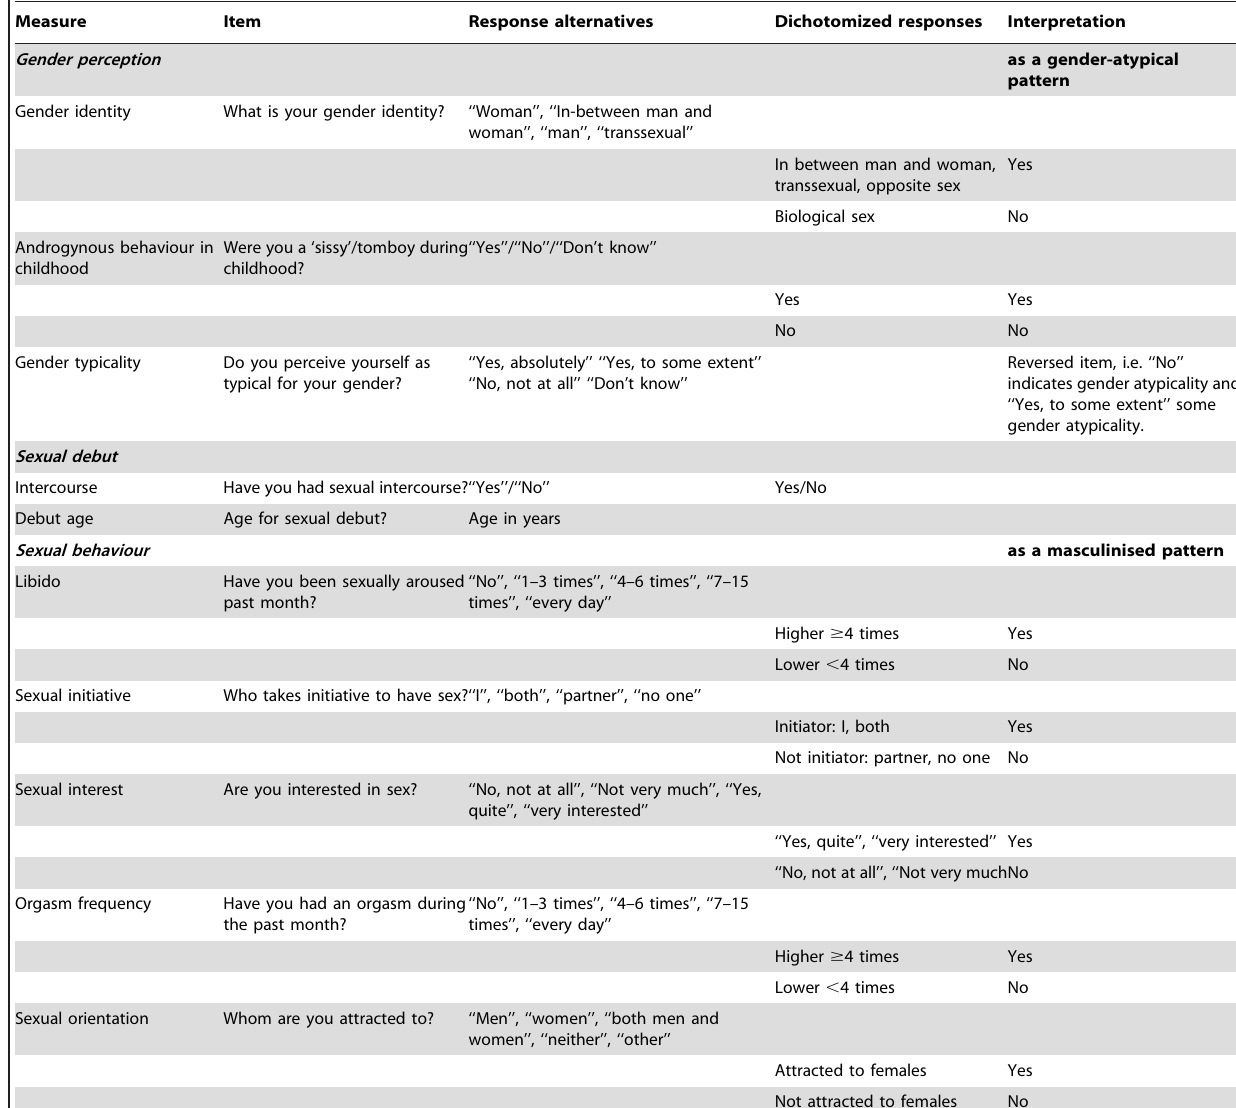
Table 2. Gender perception, sexual debut and behaviour